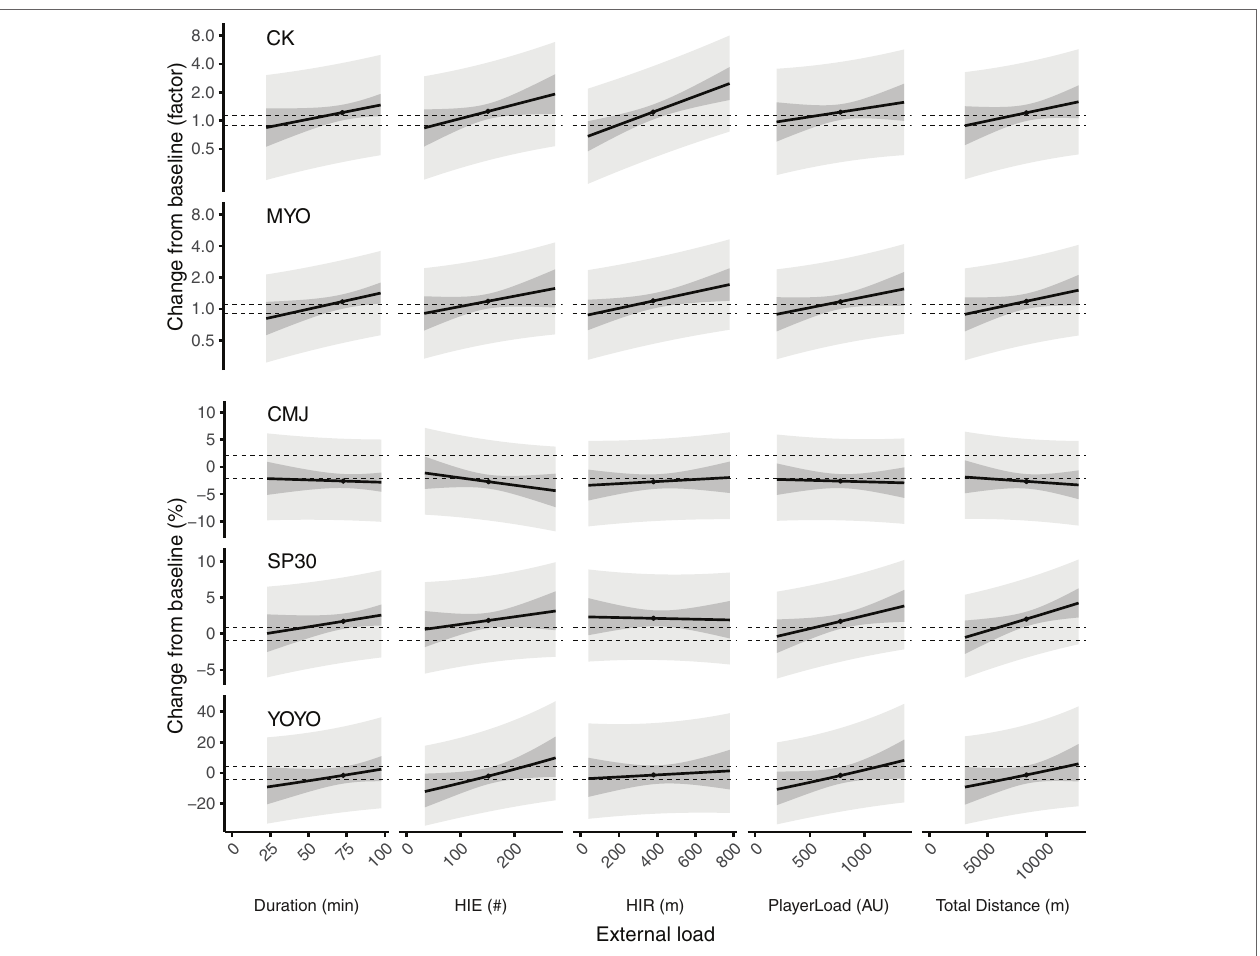
FIGURE 4 | Predicted mean change in recovery markers at 72 h post-match for different amounts of match load, after adjustments for baseline and YOYOmax. Match load values are within the range of match load values in this study and mean match load is indicated by a dot symbol. The area between the dotted lines indicates trivial changes; the dark shaded area shows 90% confidence interval, and the light shaded area shows 90% prediction